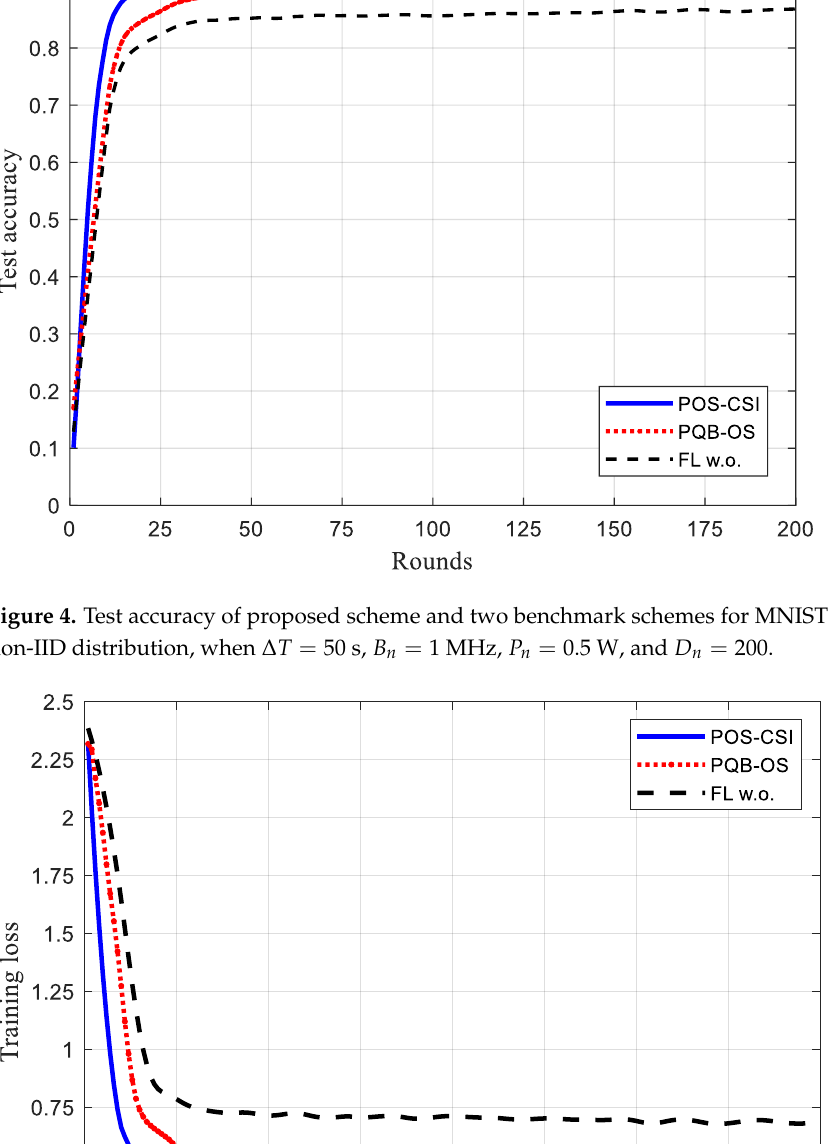
Figure 4. Test accuracy of proposed scheme and two benchmark schemes for MNIST dataset under non-IID distribution, when